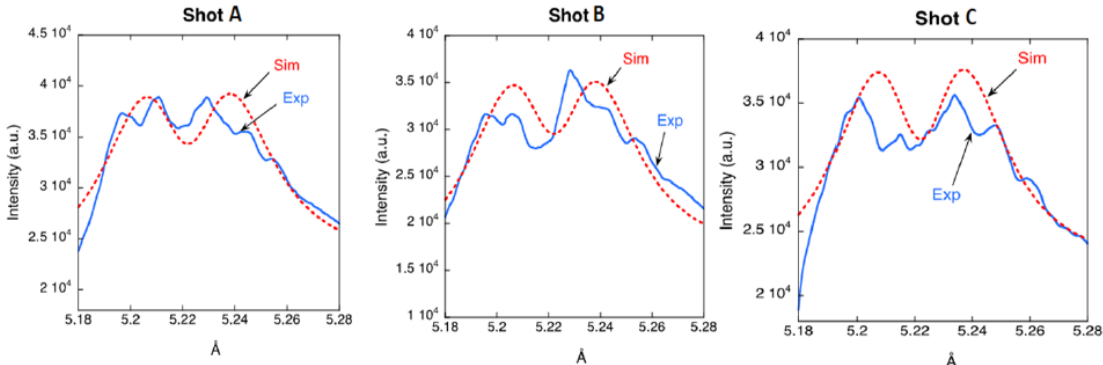
Figure 6. Experimental profiles of the Si XIV Ly-beta line in shots A, B, C (blue color in the online version) and their comparison with simulations using code FLYCHK (red color in the online version) at the electron density N e = 6 × 10 23 cm −3 and the temperature T = 500 eV [13].